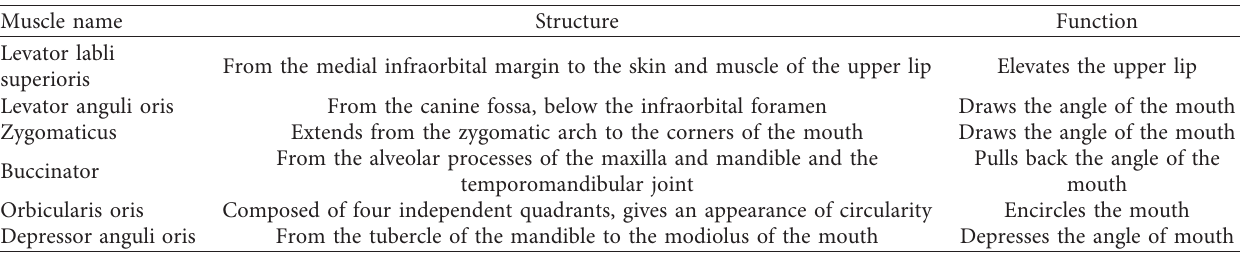
Figure 4: Picture-stitching process. (a) Feature extraction of interest and (b) representation of the image sequence splicing Table 1: The structures and functions of the major muscles.